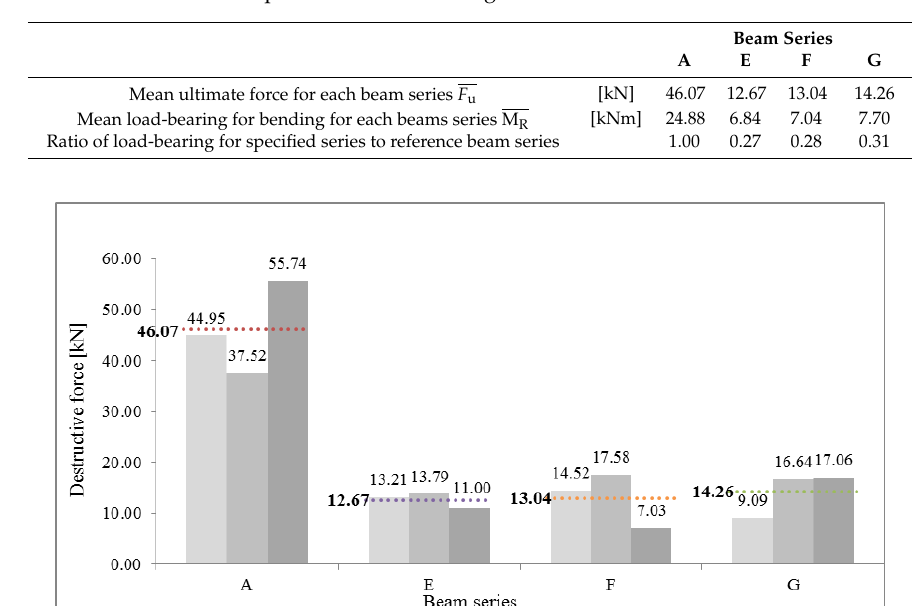
Table 2. Comparison of load-bearing for beams in the various series.